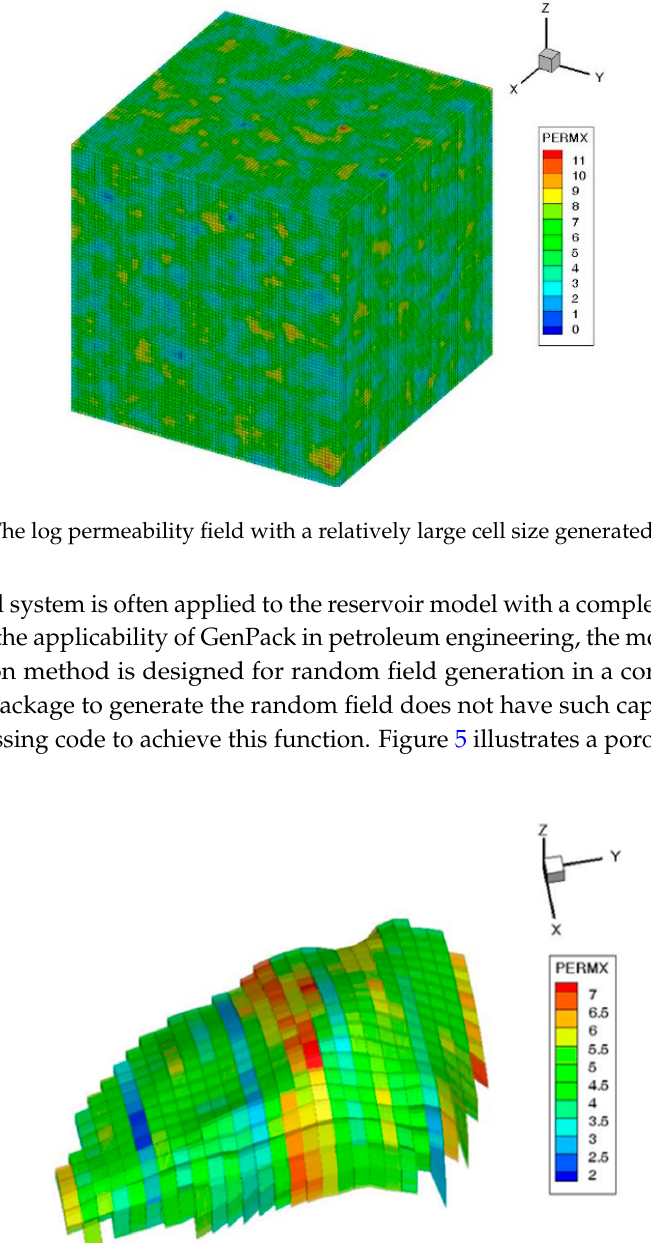
Figure 5. A random horizontal permeability field in the corner grid system generated by GenPack.